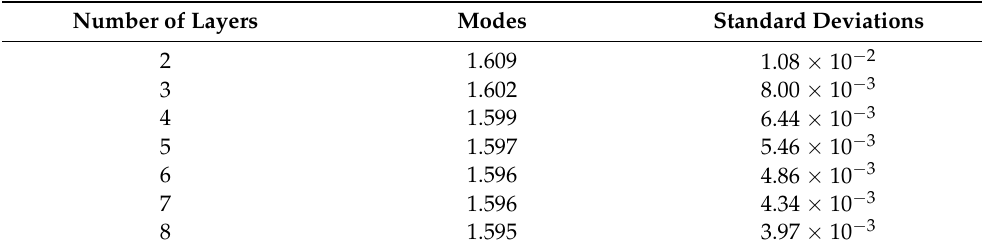
Table 1. Modes and standard deviations for the saturation density of 0.25 and the given number of layers.